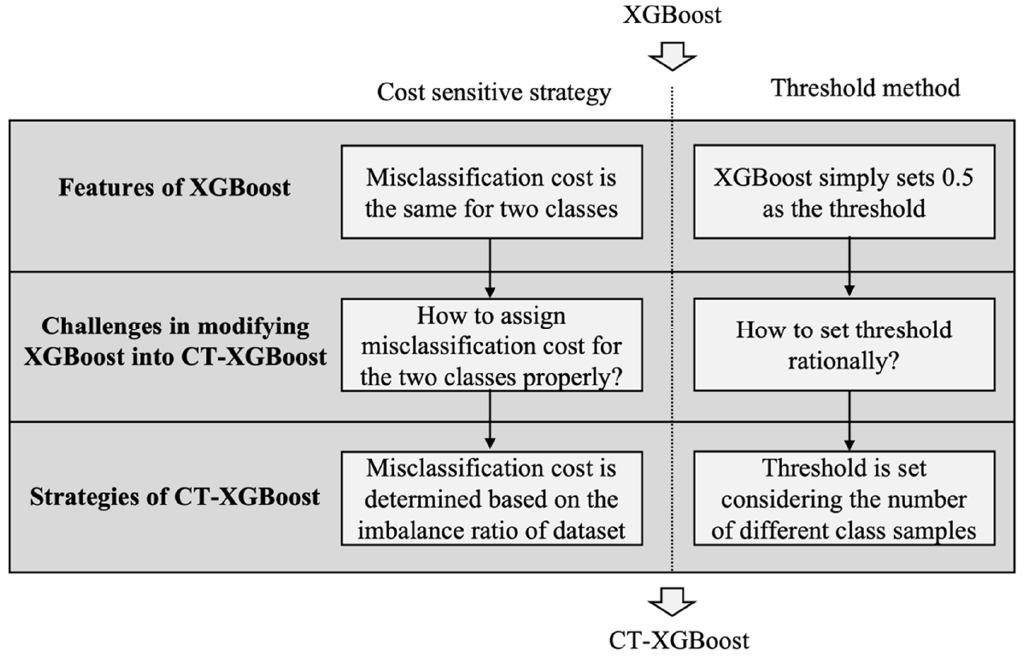
Figure 1. The process of modifying XGBoost into CT-XGBoost.